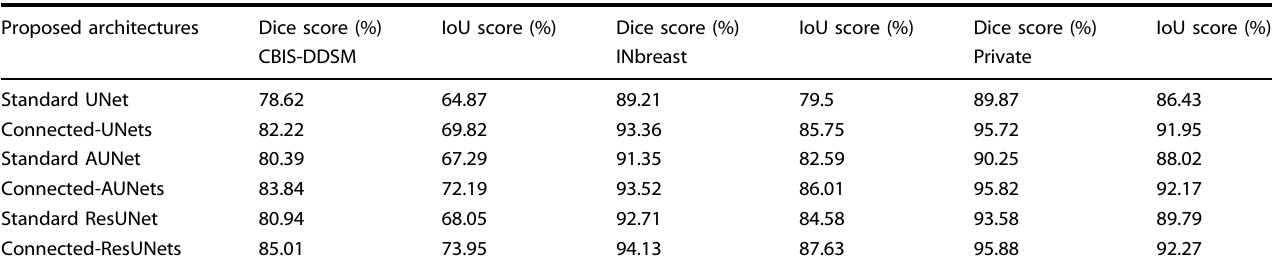
Table 2. Segmentation performance of our proposed networks on the test